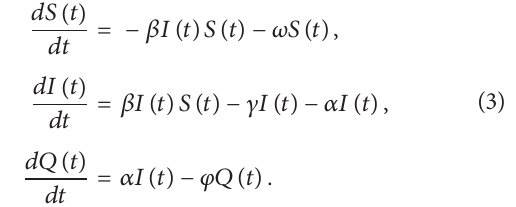
Figure 2: State transition diagram of the quarantine model.